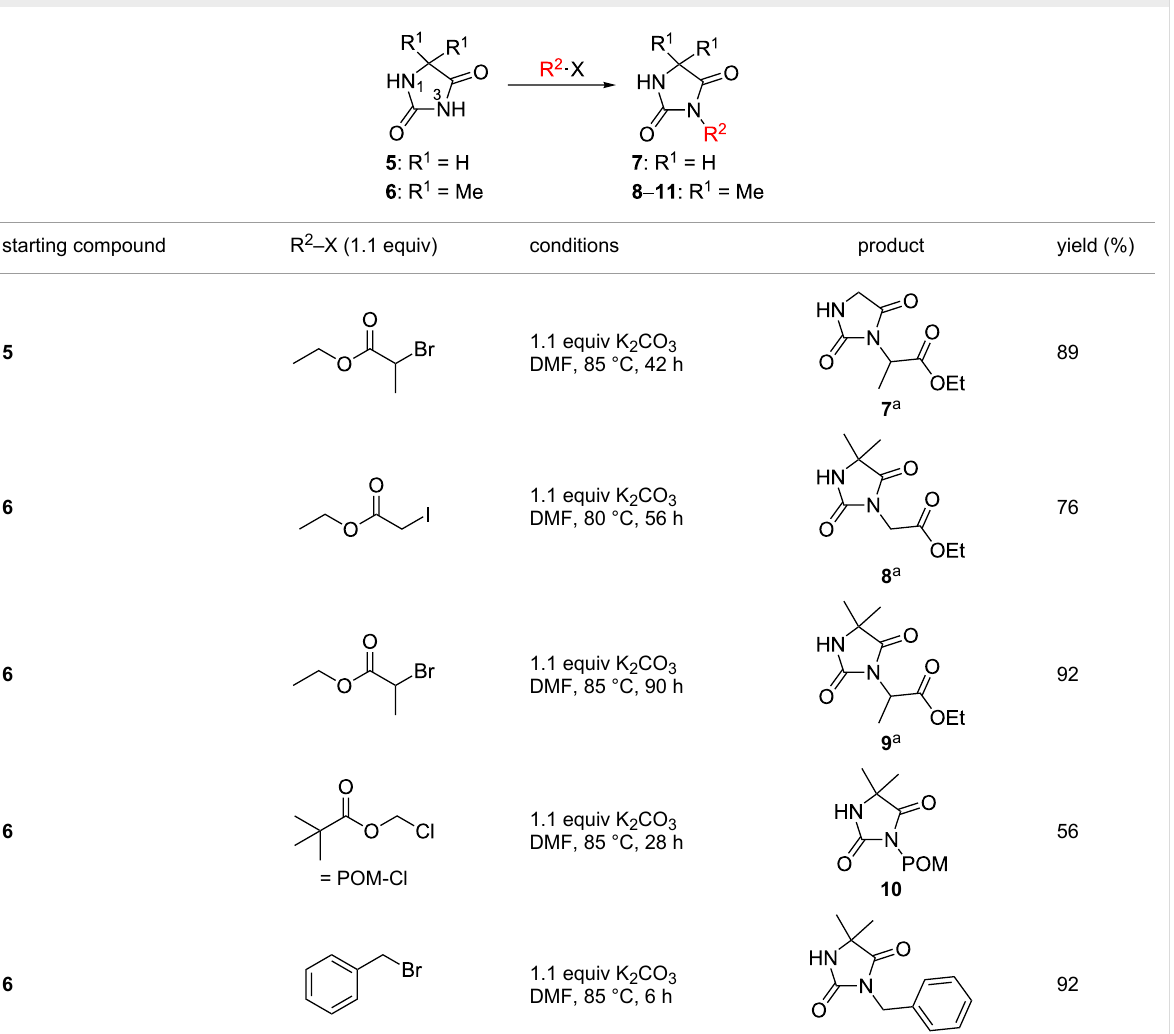
Table 1: Yields and reaction conditions for the N3-alkylation of hydantoin derivatives 5 and 6 .